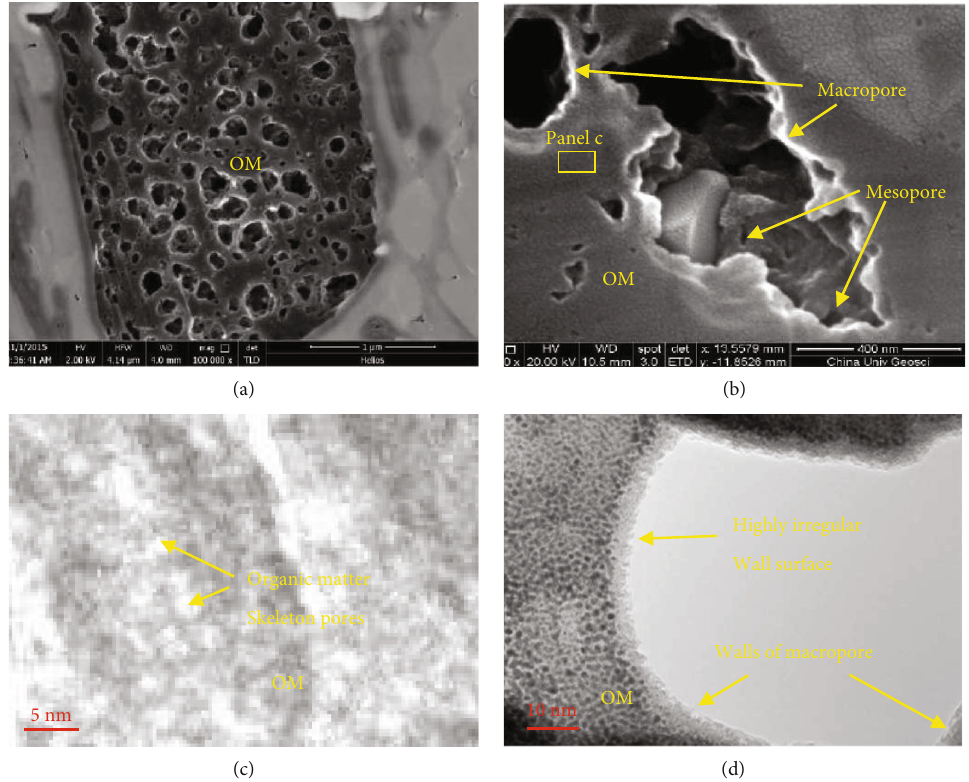
Figure 4: Characteristics of the organic pores. (a) Planar distribution characteristics of the organic pores (SEM). (b) Organic pore characteristics (SEM). (c) Characteristics of the organic matter skeleton pores (TEM). (d) Micropores in the organic pore wall (TEM).